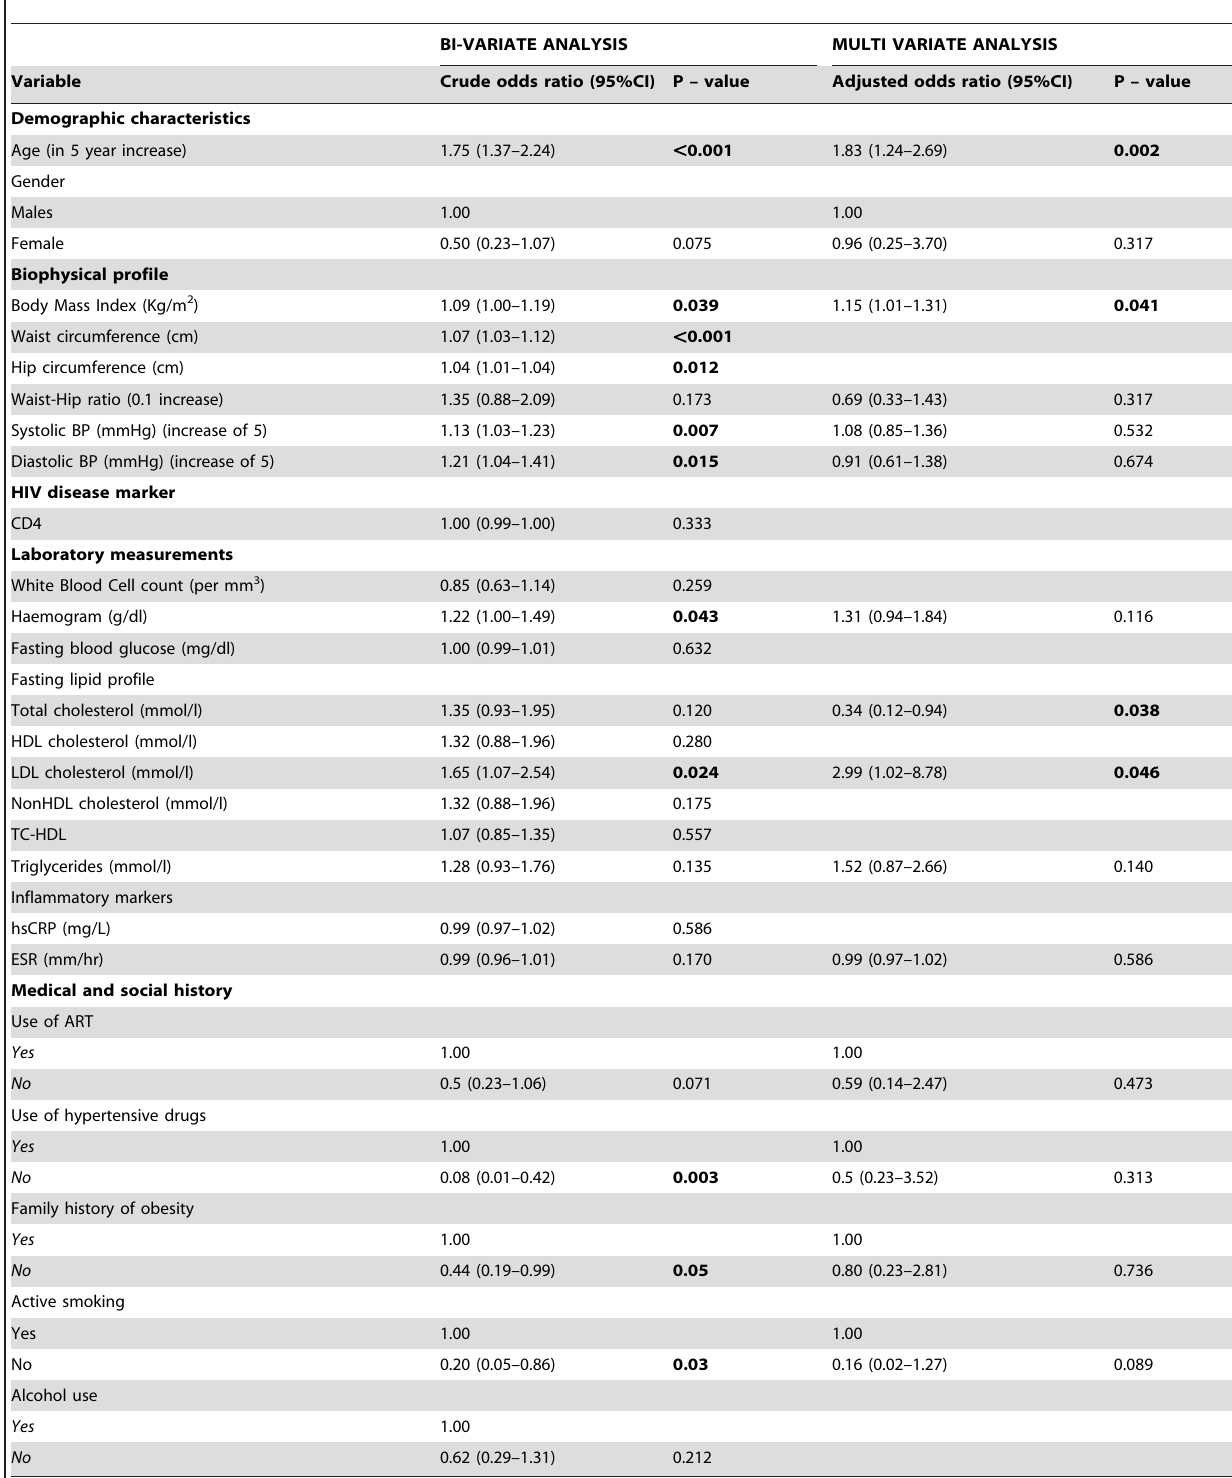
Table 2. Logistic regression for factors associated with subclinical atherosclerosis among HIV infected adults attending two large ambulatory HIV clinics in